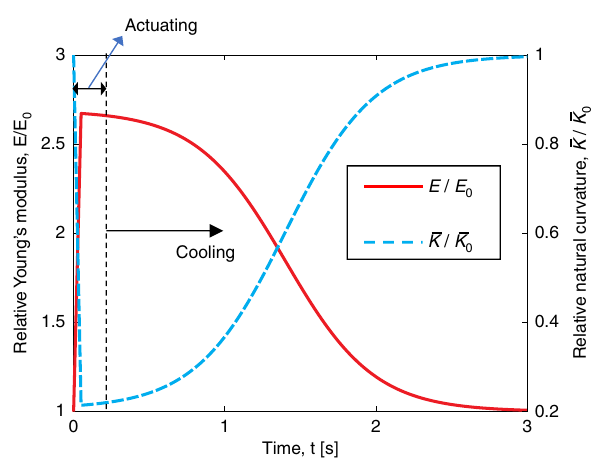
Fig. 3 Actuator characterization. Relative natural curvature (cid:1) κ = (cid:1) κ 0 and Young ’ s modulus E / E 0 as a function of time during actuating – cooling process of a single SMA actuator.